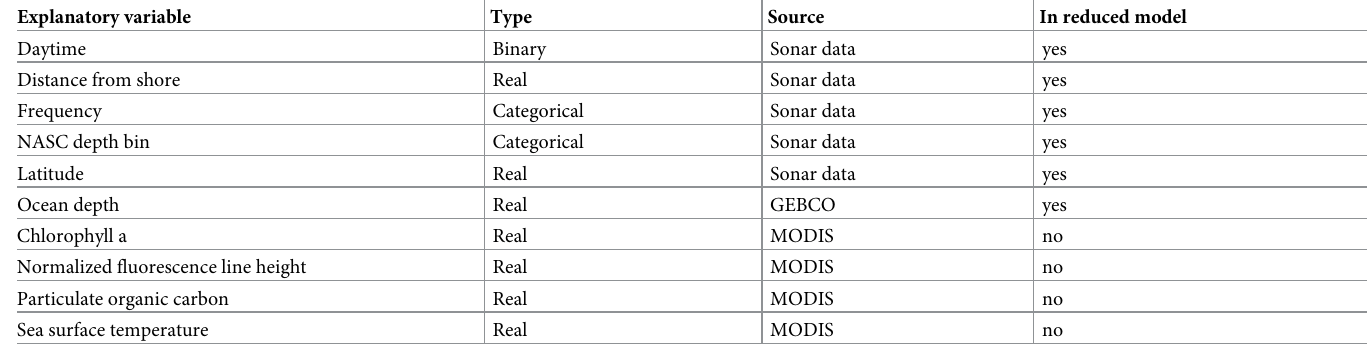
Table 1. List of explanatory variables used in the random forest models. For each variable, we list its name, type, source, and whether it was included in the reduced model. The full model includes all explanatory variables. Explanatory